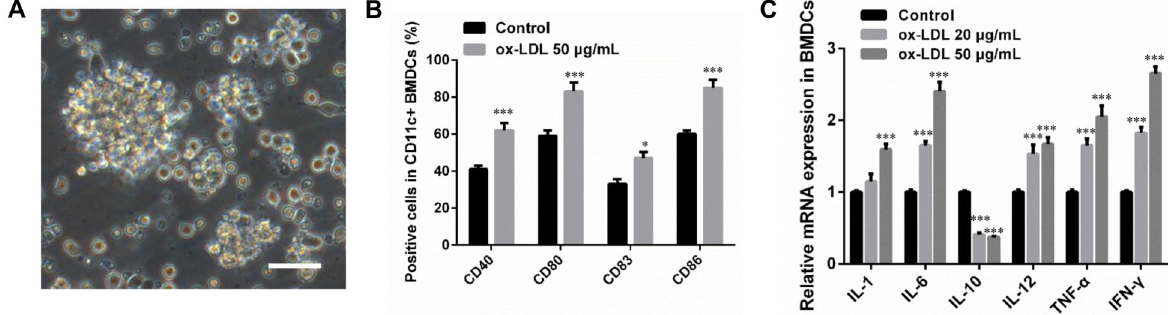
Figure 1. Bone marrow dendritic cells (BMDC) culture and stimulation with oxidized low-density lipoprotein (oxLDL). A , Typical morphology of BMDCs at day 7. Scale bar=200 m m. B , Statistical results of the surface markers of mature BMDCs by fl ow cytometry.